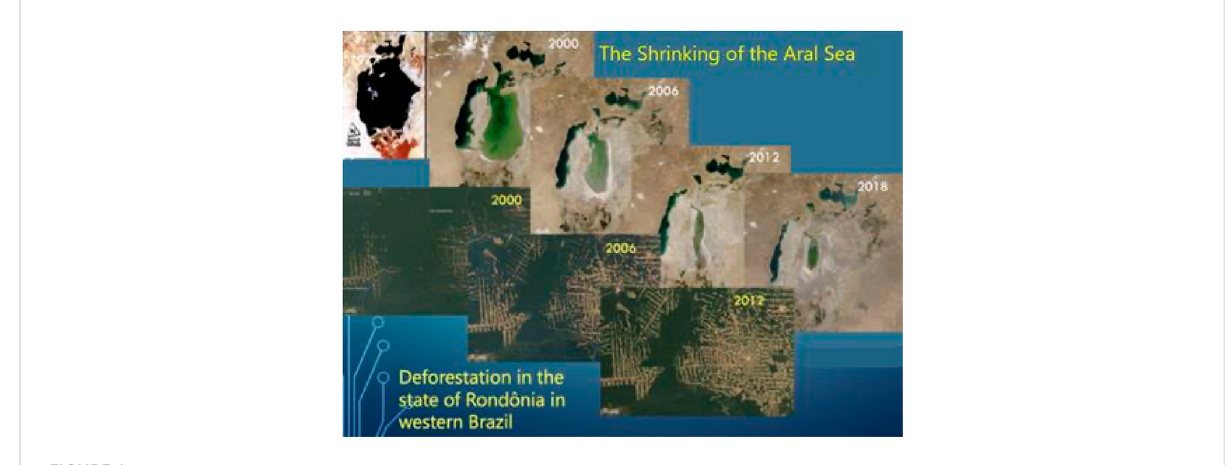
FIGURE 1 Title: Iconic examples of Landsat time series depicting land change (Source: